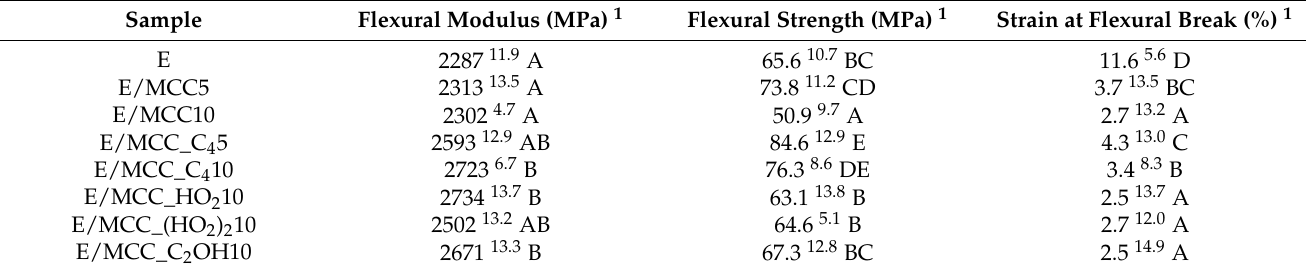
Table 4. Flexural test-derived results for epoxy and the MCC/epoxy composites.